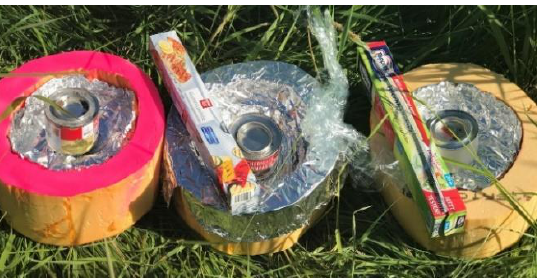
Figure 2b. Three floats in different colours with chafing fuel and aluminium foil inner linings.